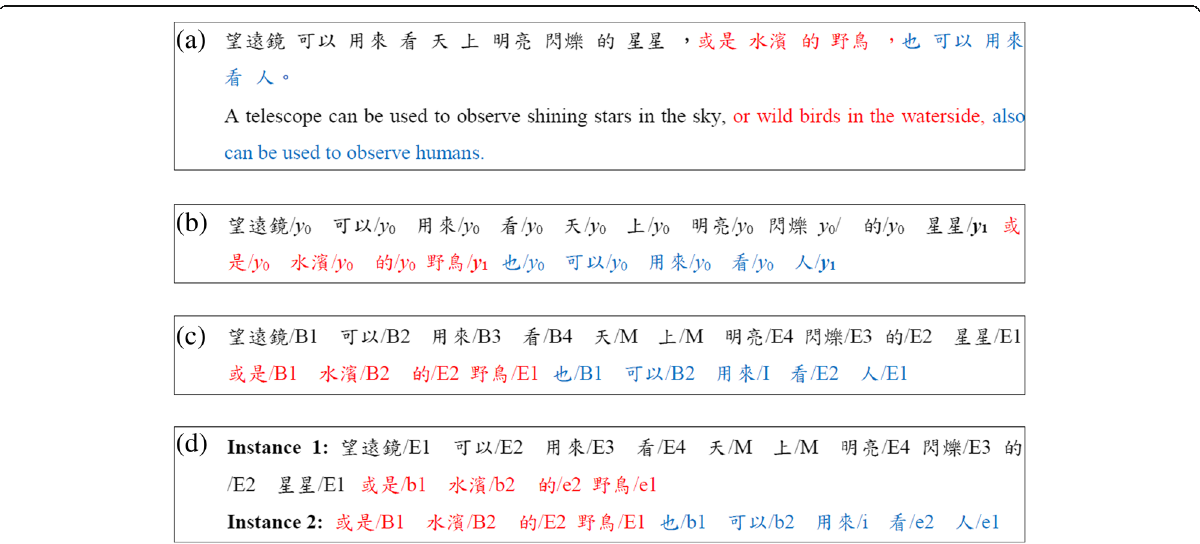
Fig. 4 Example of tag labeling for PC training: a original word or PM sequence, b tag label for the training of the bPC, c iPCst, and d iPCef. Note that each sentence-like unit is in a different color and each word is delimited by spaces